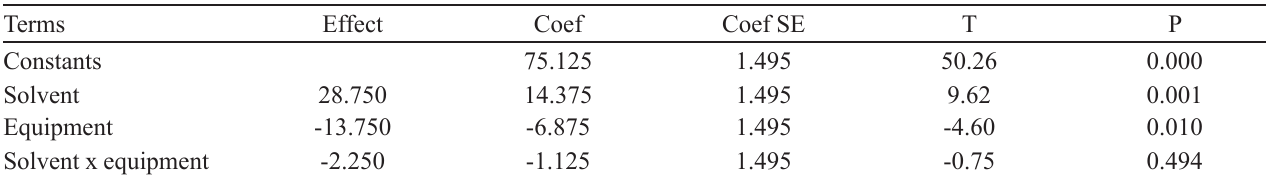
TABLE III - Test of significance for regression coefficients and adjustment indices in the model selected in the assay for assessment of uniformity in the core coating employing organic and aqueous solvents and partially and fully perforated pan coating equipment for process time